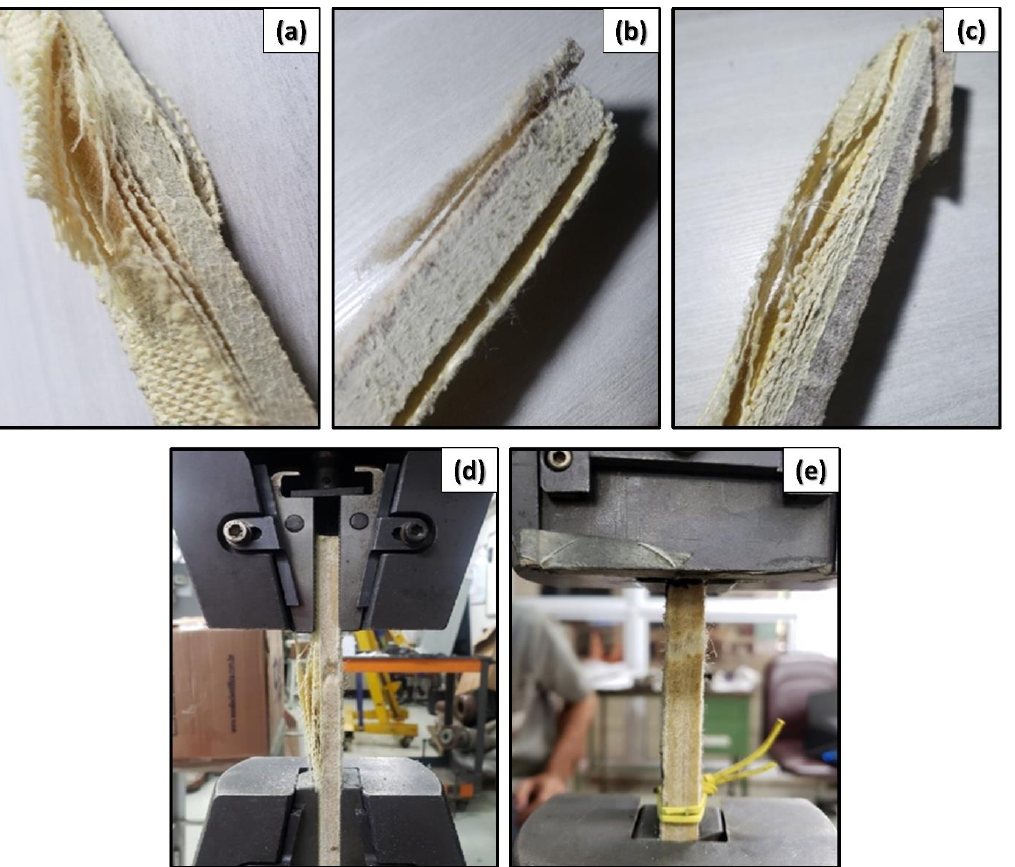
Figure 8. Tensile failure modes of composites: ( a ) E-19A/0C composite with delamination and yarn pullout and rupture evidences; ( b ) E-15A/1C composite with outermost aramid layer delamination and curaua fiber pullout and rupture evidences; ( c ) E-10A/2C composite with aramid layer delami- nation, aramid yarn rupture, and curaua fiber pullout and rupture evidences; ( d ) E-5A/3C compo- site suffering aramid layer delamination, aramid yarn rupture, and curaua fiber pullout and rup- ture; ( e ) E-0A/4C composite suffering curaua fiber pullout and rupture.